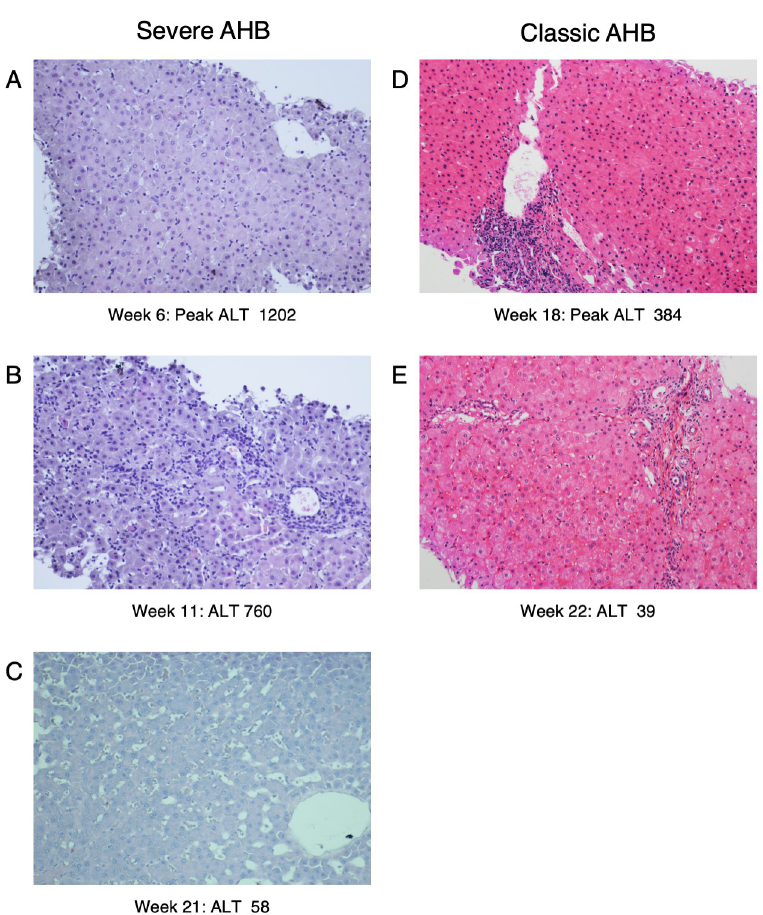
Fig 2. Comparison of the histopathologic evaluation of representative chimpanzees with severe and classic acute hepatitis B (AHB) at different time points. (A, B, C) Histopathologic changes during the course of severe AHB in CH1410 inoculated with a precore HBV mutant implicated in ALF in humans. At the time of the ALT peak (1202 IU/ L) at week 6 there was an extensive hepatocellular damage with the presence of hydropic swelling and acidophilic bodies [16] in the absence of inflammatory response (A), which appeared later at week 11 (B), followed by complete resolution (C). (D and E) Histopathologic changes during the course of classic AHB in CH5835 inoculated with wild- type HBV. In this animal the ALT peak (384 IU/L) at week 18 coincided with extensive necroinflammatory changes, followed by resolution of the disease (hematoxylin and eosin, x20).